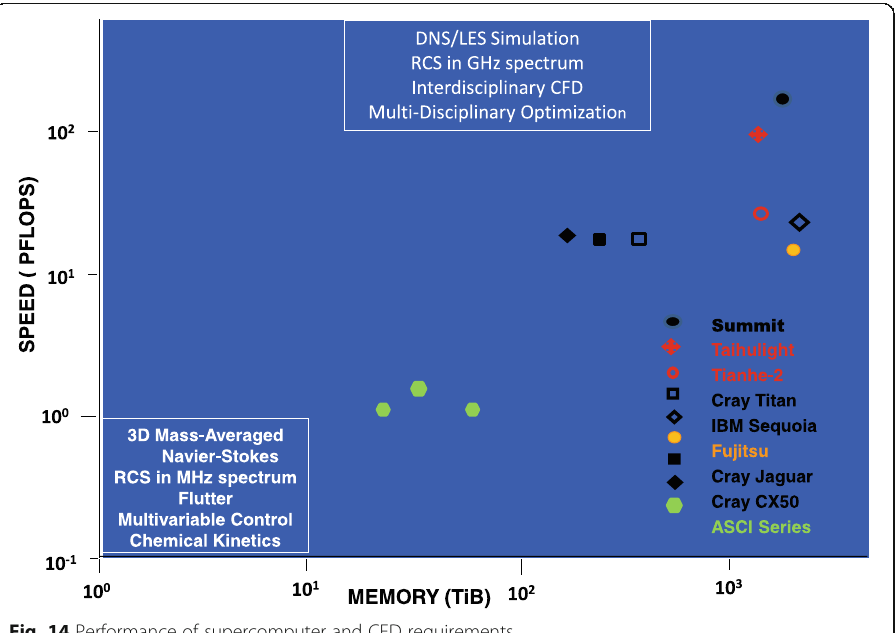
Fig. 14 Performance of supercomputer and CFD